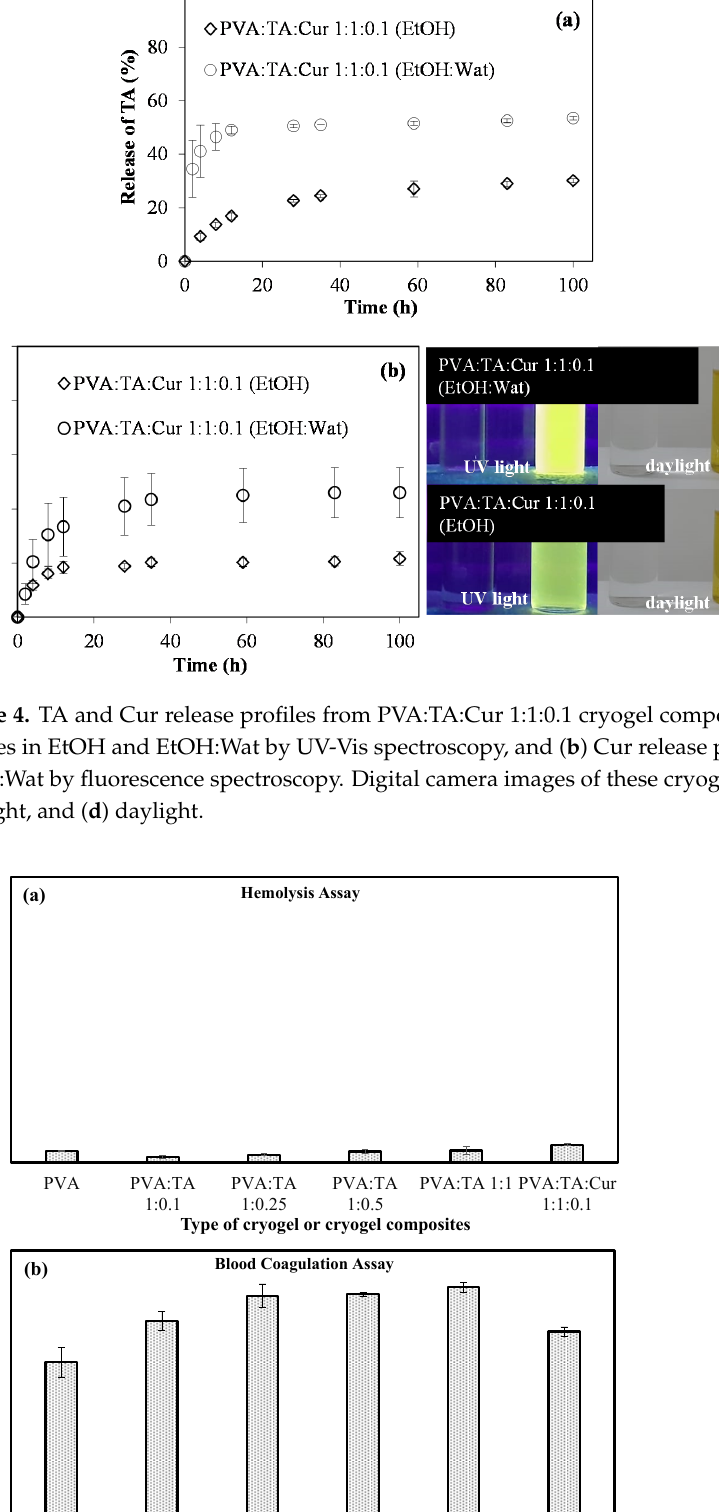
Figure 5. Hemocompatibility of PVA cryogel, PVA:TA, and PVA:TA:Cur cryogel composites according to (a) hemolysis assay and (b) blood coagulation assay. From the hemolysis test results, the PVA cryogel and PVA:TA cryogel composites have slight hemolytic effects, with hemolysis rates of 4.10 ± 0.10%, 2.00 ± 0.43%, 2.70 ± 0.35%, 3.81 ± 0.73%, and 4.20 ± 1.53%, respectively. On the other hand, the PVA:TA:Cur cryogel/composite shows little hemolytic effect, with a hemolysis rate of 6.22 ± 0.40% after contact with blood. When examining the blood coagulation test results, the PVA cryogel,